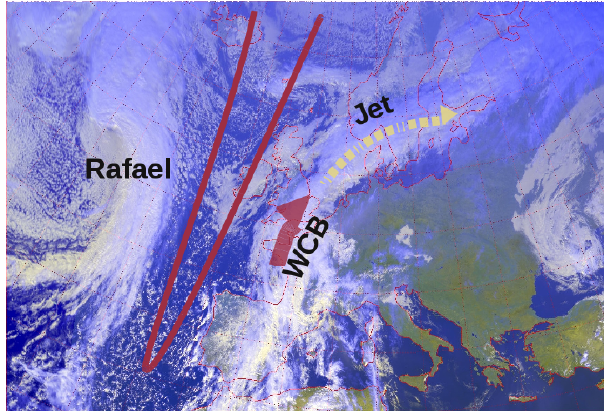
Figure 1. Real-world context for the T-NAWDEX-Falcon case used for the examples: visible Meteosat satellite image of Europe and the North Atlantic of 12:00UTC, 19 October 2012 (Meteosat op- erated by EUMETSAT, image processing by DLR-IPA). Important features are the narrow trough to the west of the British Isles (dark red line), the former Hurricane Rafael and the WCB manifest in the cloud band east of the